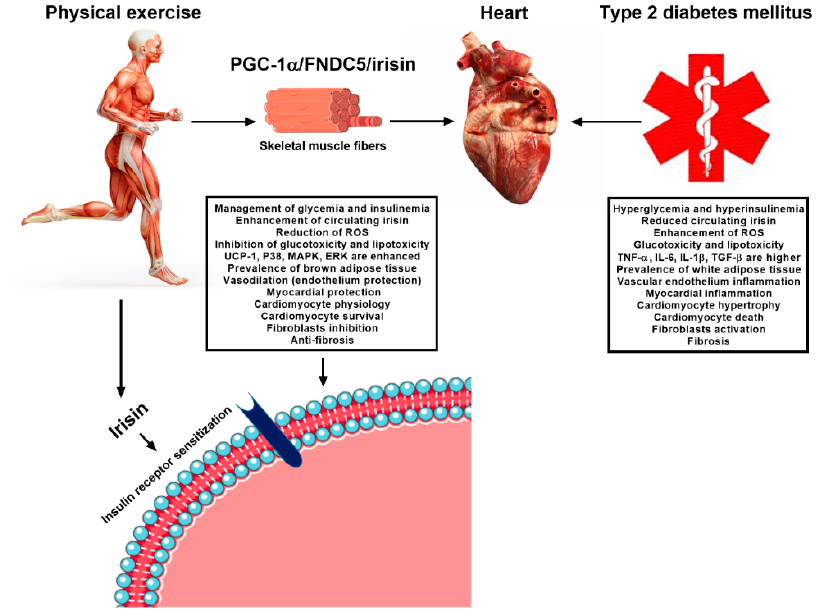
Figure 3. Exercise-linked irisin: consequences on cardiovascular system in T2DM. In T2DM there are many physiological changes that interfere with the cardiovascular system functioning like: hyperglycemia and hyperinsulinemia; reduced circulating irisin; enhancement of ROS; glucotoxicity and lipotoxicity; higher levels of pro-inflammatory proteins such as TNF- α , IL-6, IL-1b, TGF- β ; prevalence of white adipose tissue; vascular endothelium inflammation; myocardial inflammation; cardiomyocyte hypertrophy; cardiomyocyte death; fibroblasts activation; fibrosis; and reduced insulin receptor sensitization. Although, the regular practice of exercise can inhibit these outcomes through many different ways like enhancing the UCP-1 expression in white adipose tissue cells inducing conversion of these cells into brown type fat cells. The production of irisin also leads to phosphorylation of p38 MAPK and activation of ERK, producing an increase in the expression of betatrophin, which generates proliferation and regeneration of beta-pancreatic cells.